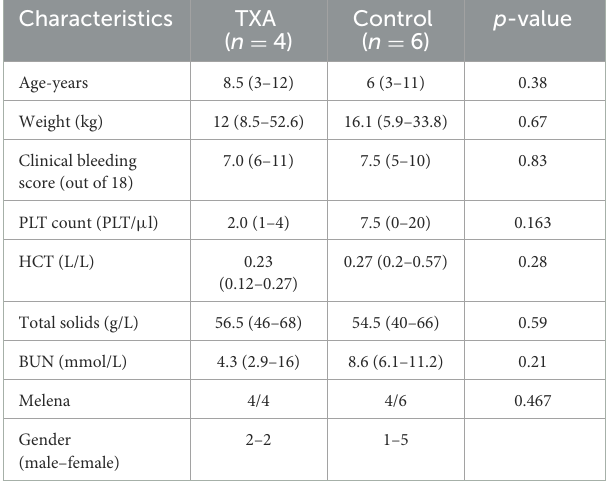
TABLE 1 Baseline characteristics in the 10 included dogs with immune thrombocytopenia in the tranexamic acid group (TXA) and the control groups.